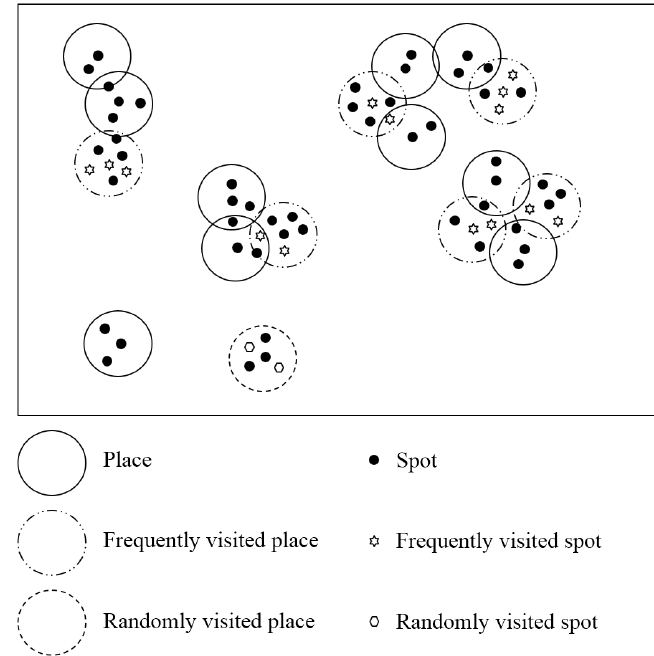
Figure 4. Candidate places ( S u